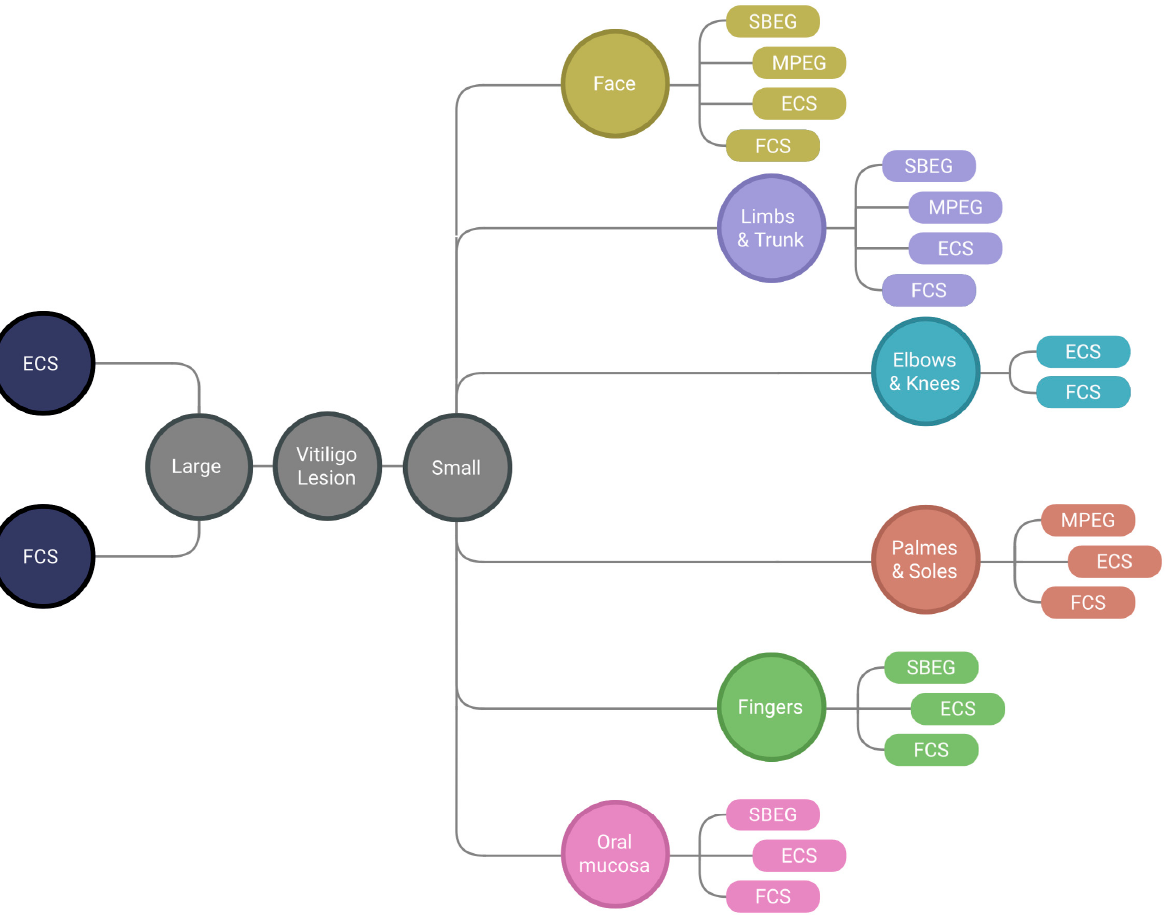
Figure 1. Method selection based on lesion location. SBEG—suction blister epidermal grafting; MPG—mini-punch grafting; ECS—epidermal cell suspension; FCS—follicular cell